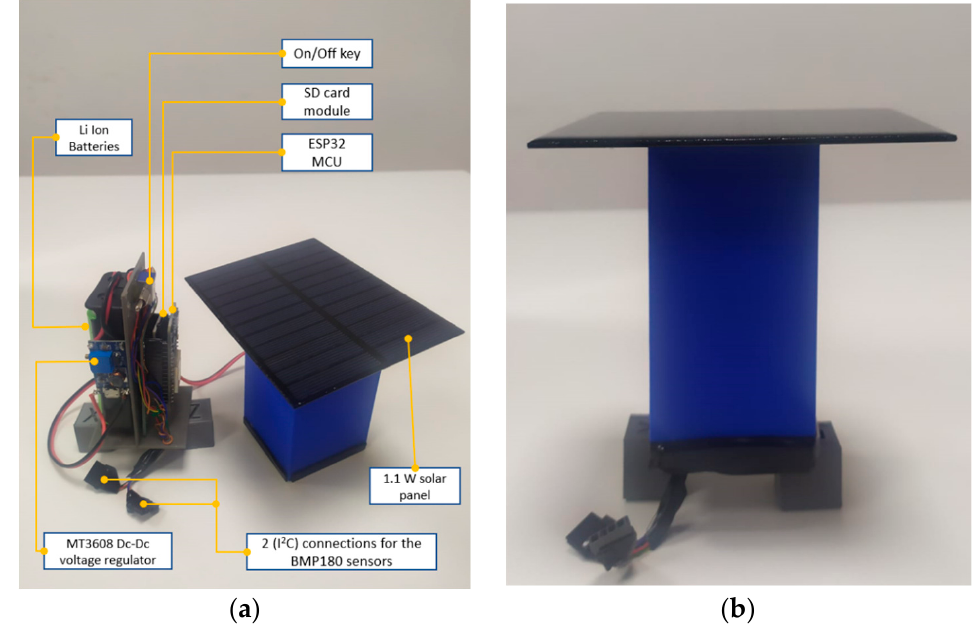
Figure 3. The IoT tensiometer prototype: ( a ) The components; ( b ) sealed prototype.